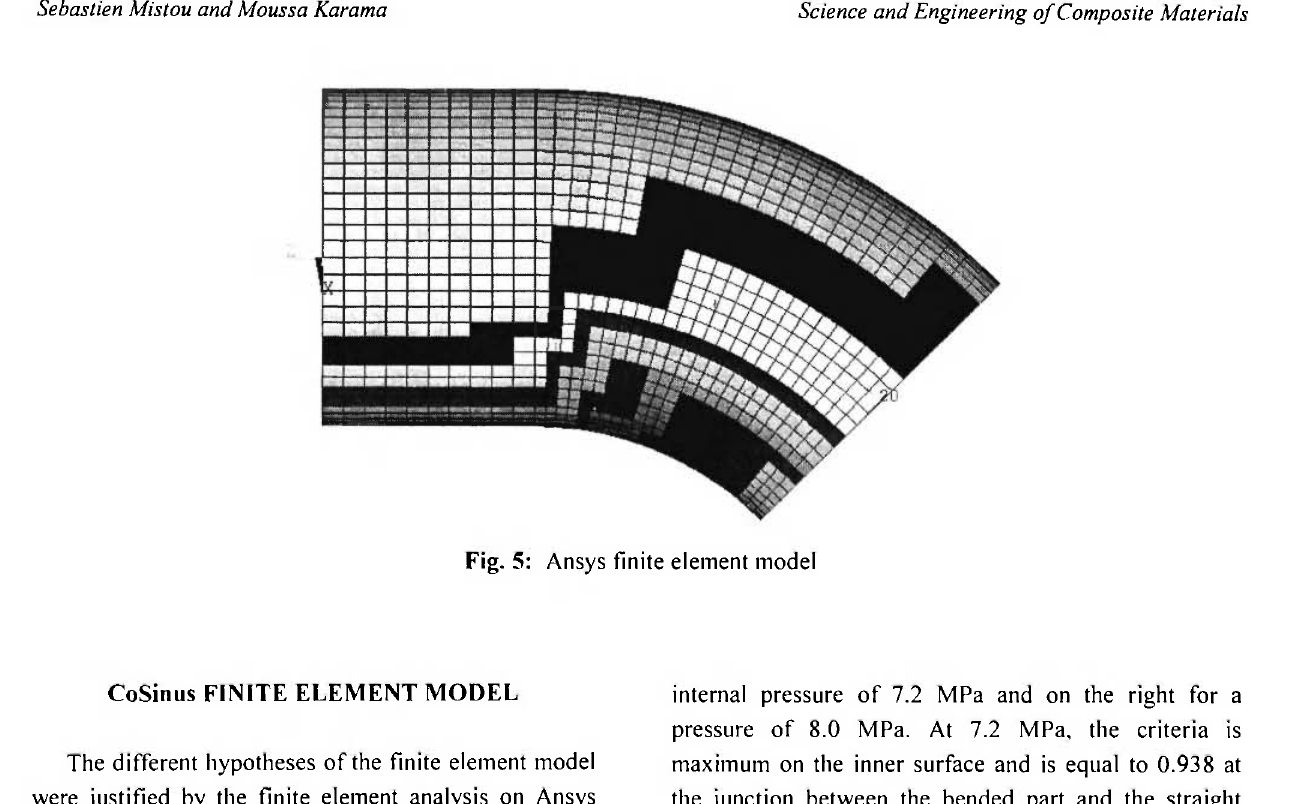
Fig. 5: Ansys finite element